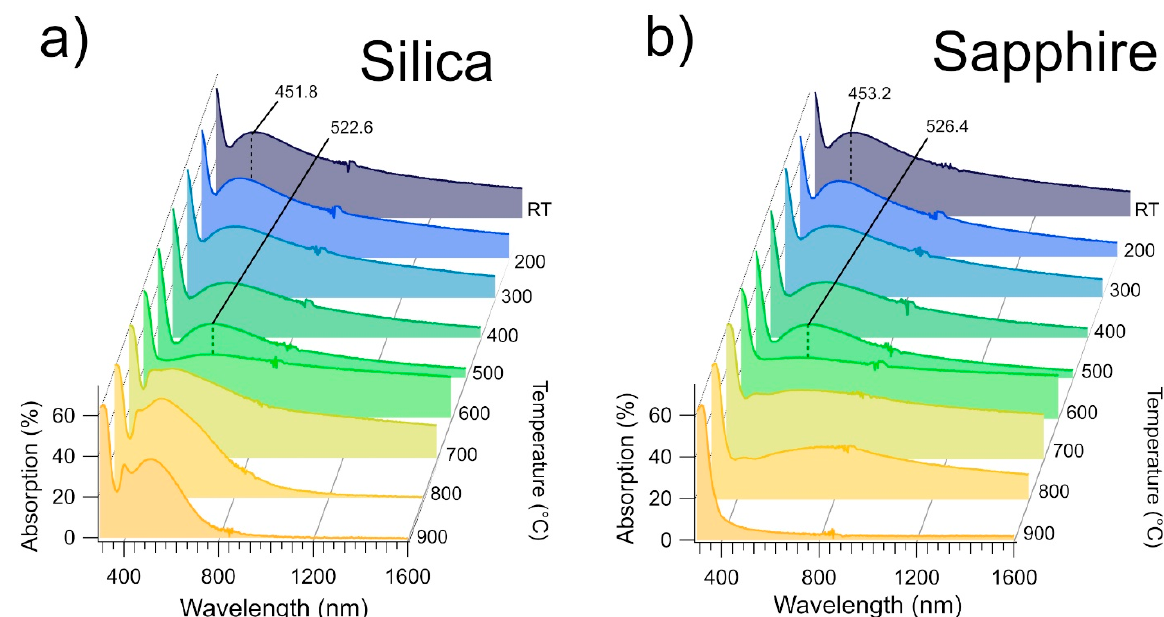
Figure 3 . ( a ) Optical absorption spectrum of the Ag/TiO 2 (AgTi 50–50) film on silica as a function of the annealing temperature. ( b ) Optical absorption spectrum of the Ag/TiO 2 (AgTi 50–50) film on sapphire as a function of the annealing temperature.